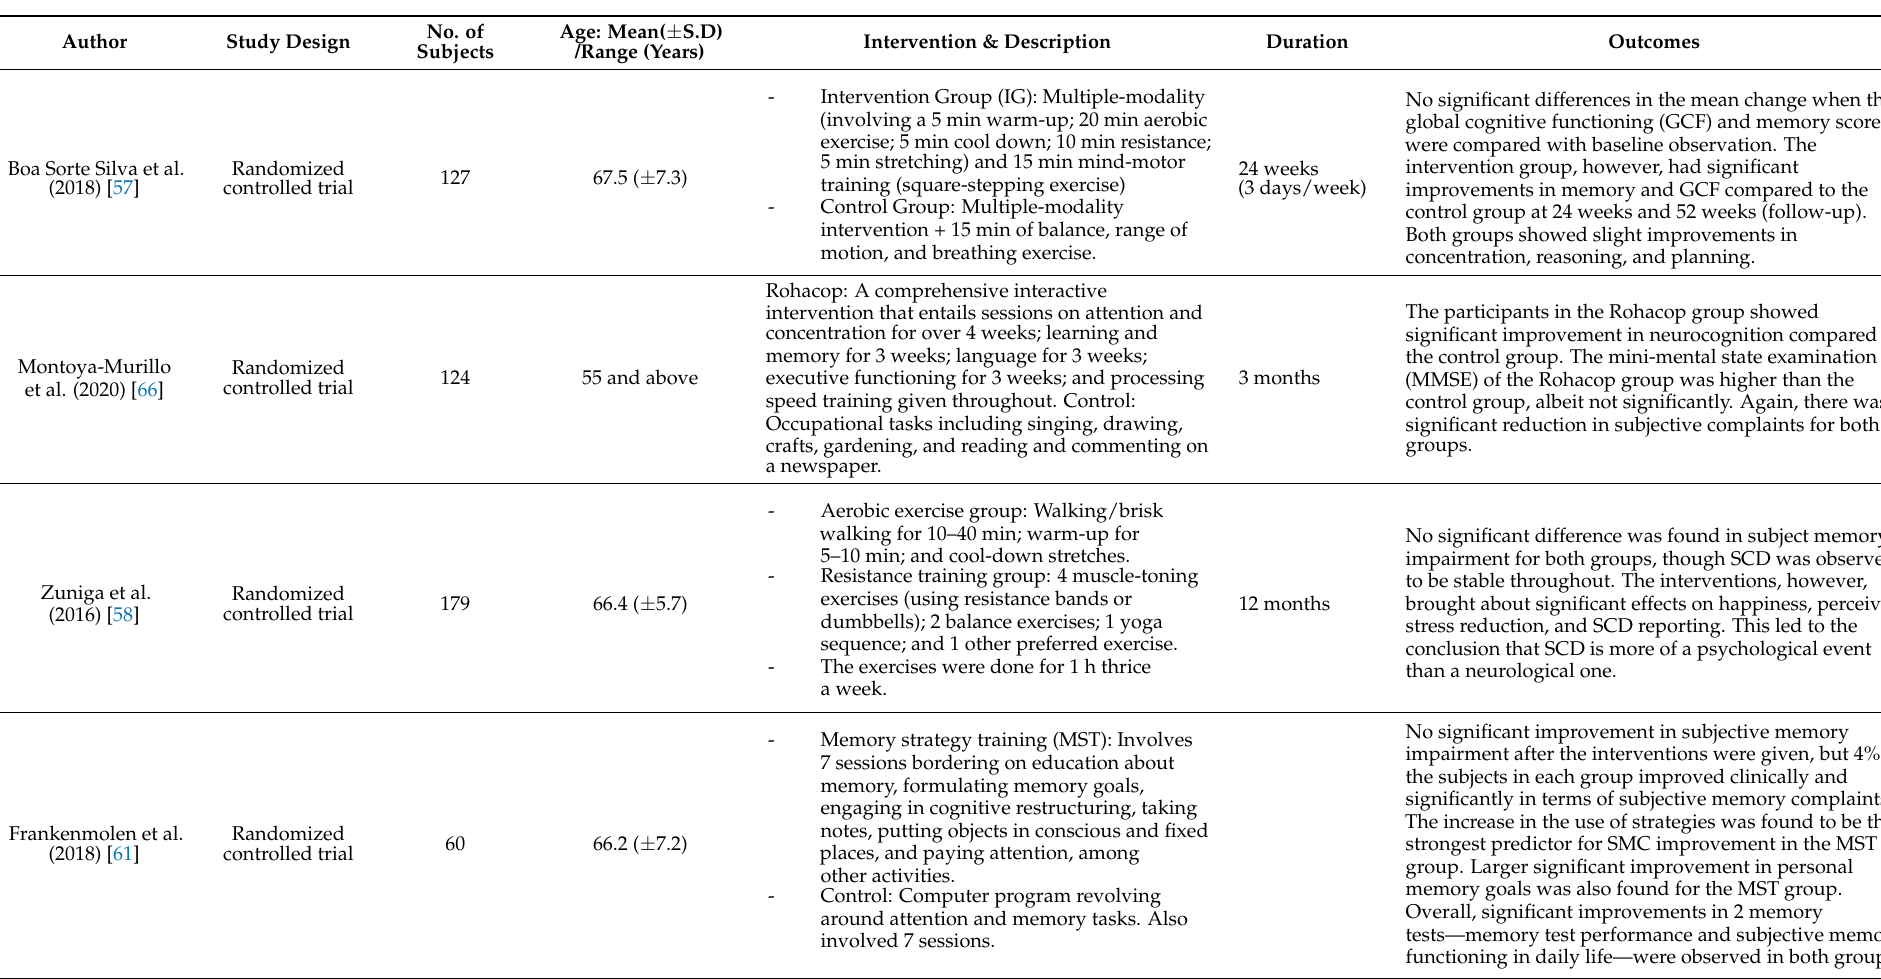
Table 1. Summary of study